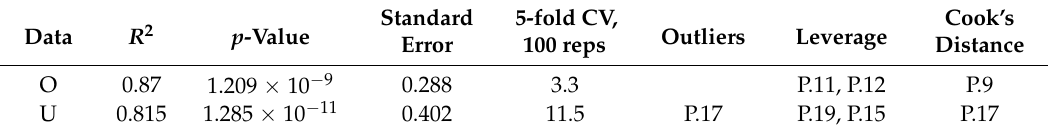
Table 3. Results for V F .1 with the original Rico dataset (O) and updated (U) datasets (including